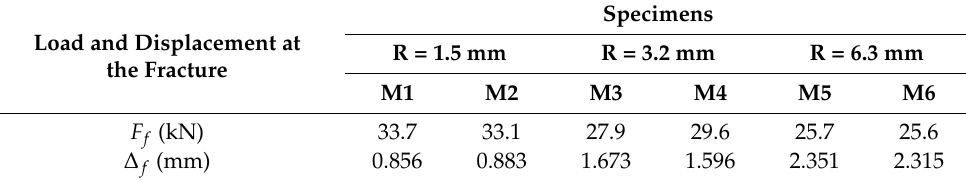
Figure 5. Illustration of X80 pipeline steel specimen. Table 2. Test results of the X80 pipeline steel.